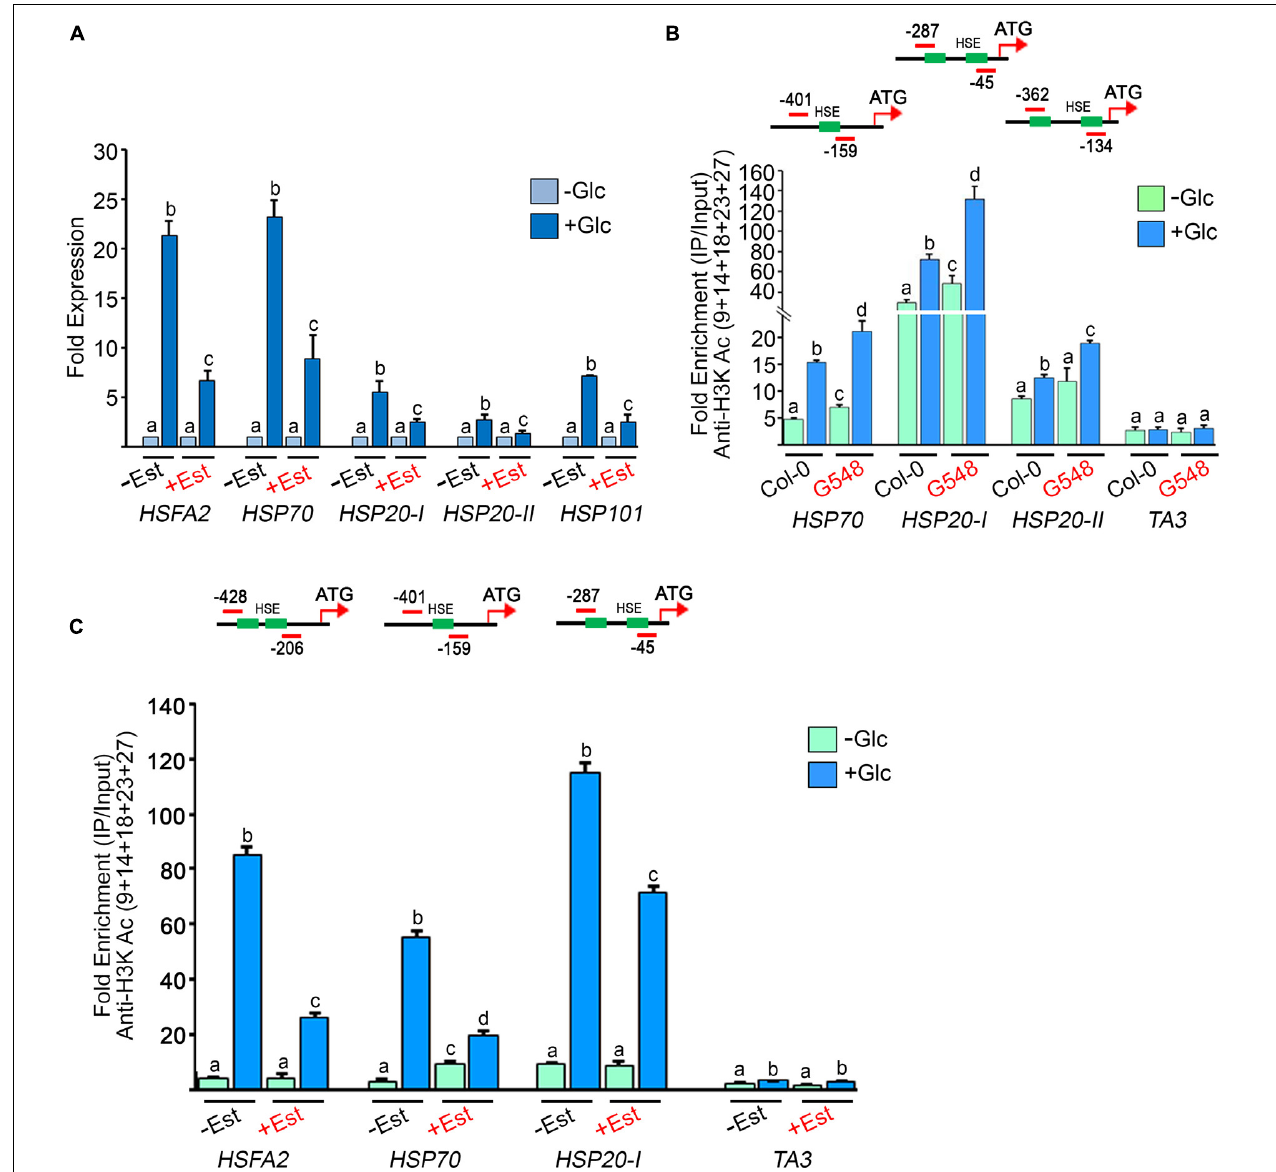
FIGURE 5 | Glucose through TOR drives HS gene expression by incorporating histone H3 acetylation (A) RT-qPCR expression of HS genes in Arabidopsis tor estradiol-inducible RNAi line ( tor-es1 ) under Glc lacking/sufficiency. RT-qPCR analysis was performed on three independent biological replicates ( n = 3). Bar plots represent mean values, and error bars denote SE. Different letters denote statistical differences at p < 0.05 as assessed by one-way ANOVA and Tukey’s HSD post hoc test. (B) ChIP-qPCR showing enrichment of histone H3K acetylation at the promoters of HS loci under Glc lacking/sufficiency in Col-0 and TOR overexpression line G548. Seven-day-old Arabidopsis Col-0 and G548 seedlings were starved for 24 h under a sugar-deficient medium. Following starvation, seedlings were subjected to 3 h of Glc treatment (167 mM) and crosslinked with 1% formaldehyde. The data shown are representative of one biological replicate. The experiment was repeated two times with similar results. (C) ChIP-qPCR showing enrichment of histone H3K acetylation at the promoters of HS loci under Glc lacking/sufficiency in tor-es1 . In panels (A,C) , 5-day-old tor-es1 seedlings were transferred to 0.5X MS medium, containing 20- µ M β -estradiol for 4 days. Following estradiol treatment, seedlings were starved for 24 h under the sugar-deficient medium. Following starvation, seedlings were subjected to 3 h of Glc treatment (167 mM). For mock treatment, seedlings were transferred to an equal volume of DMSO (as used for estradiol), containing MS medium. Promoter fragments containing cis- acting HSEs were immuno-precipitated using an anti-H3K Ac (9 + 14 + 18 + 23 + 27) antibody. The amount of immuno-precipitated promoter DNA was calculated by comparing samples treated without or with an anti-Histone H3K (9 + 14 + 18 + 23 + 27) acetyl antibody. Ct values without and with antibody samples were normalized by input control. TA3 is a highly heterochromatinised DNA and was used as a negative control in the ChIP assays. The green boxes represent putative heat shock elements (HSEs) in the HS gene promoters. ChIP-qPCR analysis was performed on three technical replicates ( n = 3) from a single representative experiment. The experiment was independently repeated two times (biological replicates; n = 2). Different letters between samples (Col-0 vs. G548 and –Est vs + Est) in each gene denote statistical differences at p < 0.05 as assessed by one-way ANOVA and Tukey’s HSD post hoc test.